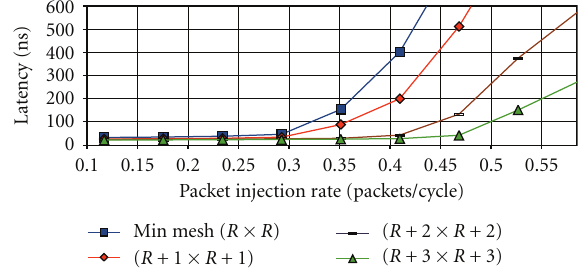
Figure 16: Latency as mesh size is varied for ami49